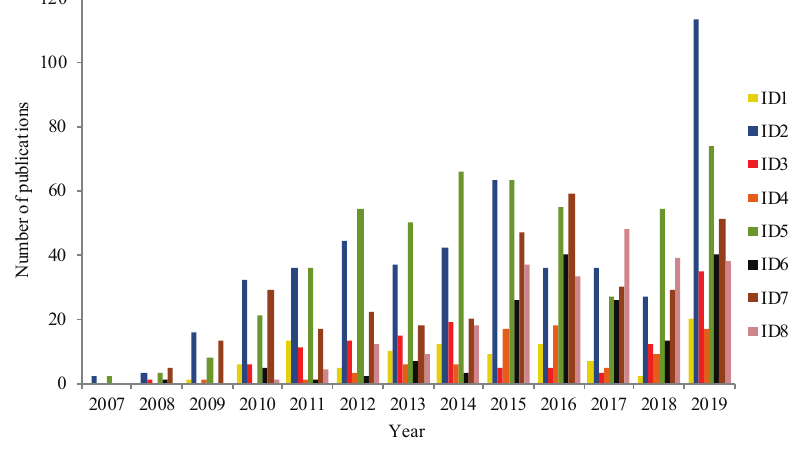
Figure 2. Research trends of EVs and distribution networks,